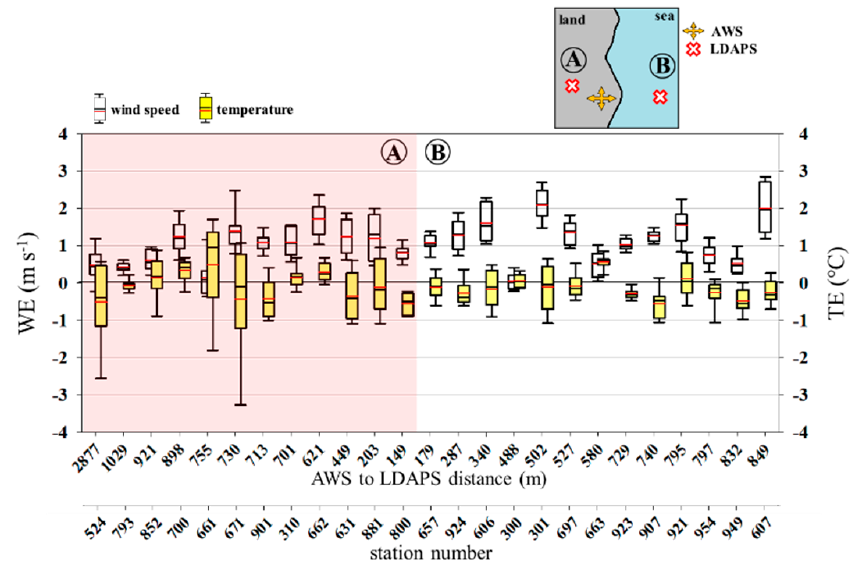
Figure 10. Box plots of the WEs and TEs at the Rc AWSs. Left panel shaded in blue and right panel shaded in red represent the cases that the LDAPS grid point closest to a comparison AWS is located at the land ( ○ A ) and sea ( ○ B ), respectively.